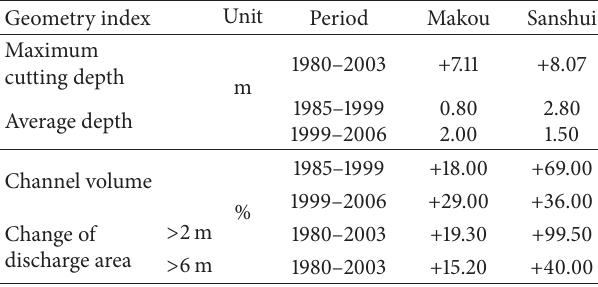
Table 5: Variation of channel geometries in Sanshui and Makou.